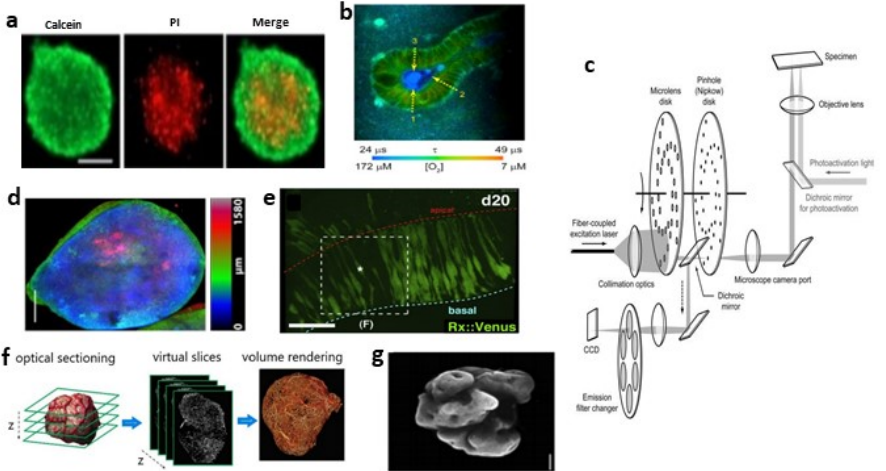
Figure 2. ( a ) WFFM was used to observe viable and dead cells in the cancer spheroid. Stained with calcein-AM (green) and propidium iodide (PI, red). Reproduced from Reference [81] under the Cre- ative Commons License (CC BY 4.0); ( b ) FLIM imaging revealed presence of O2 micro-gradients between basal and apical membranes in resting organoids. Reprinted from Biomaterials, 146, D.B.;